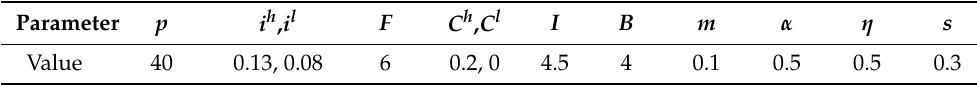
Table 9. Initial parameter values (when the active online platform charges investors higher informa- tion fees).